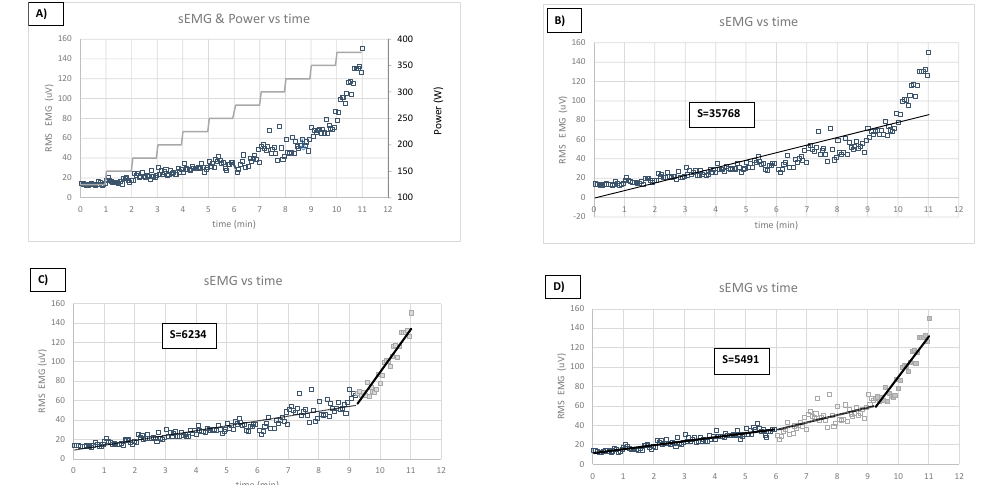
Figure 1. Multi-regression method step by step, S represents the residual sum of squares (RSS). ( A ) Original data, workload (gray line), and EMG amplitude for each epoch. ( B ) Best single-segment regression. ( C ) Better two-segment regression. ( D ) Better 3-segment regression.